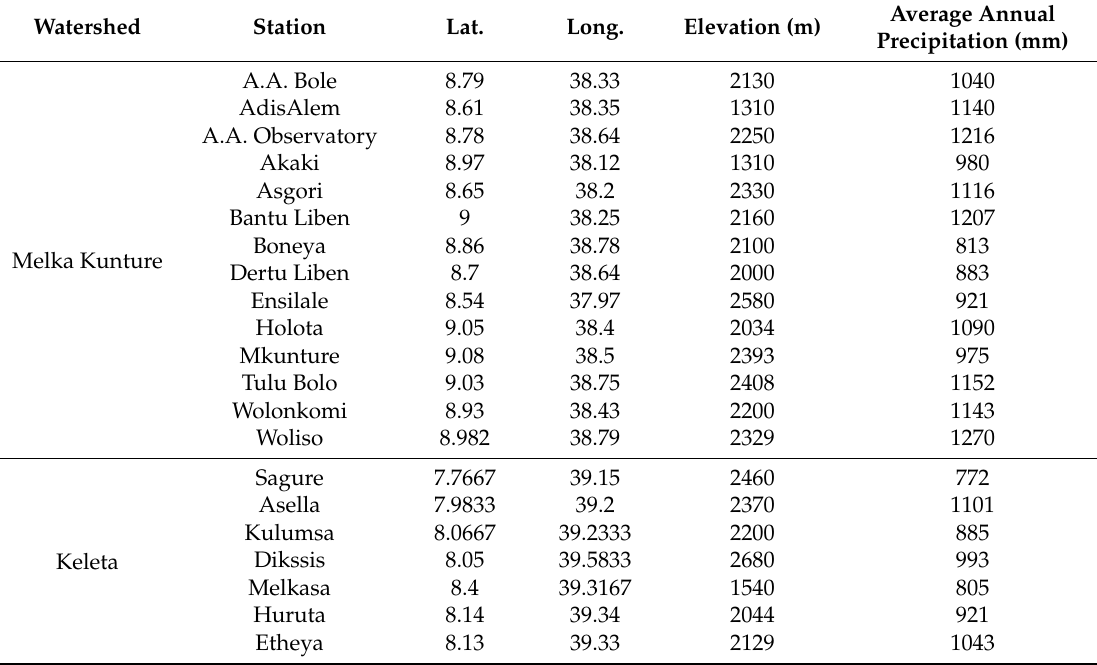
Table 1. Description of conventional weather data meteorological stations